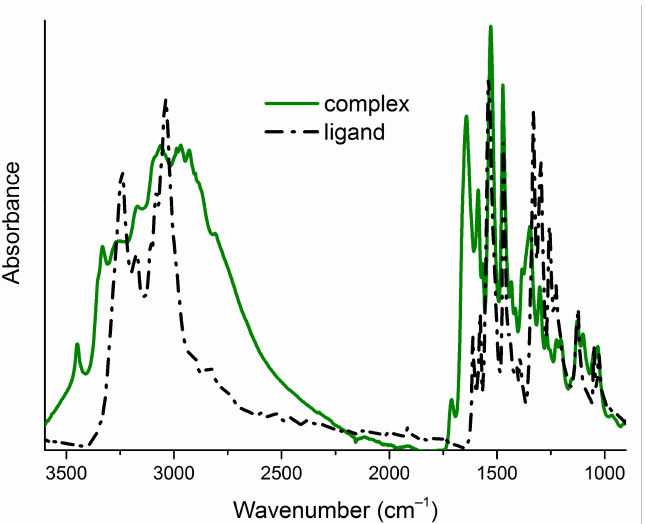
Figure 2. Attenuated total reflection infrared (ATR-IR) spectra of one exemplary pair of a free ligand ( L5 ) and a complex ( 5 ) in the range of 3600–900 cm –1 . ATR-IR spectra of all studied compounds are gathered in the Supplementary Materials (Figure